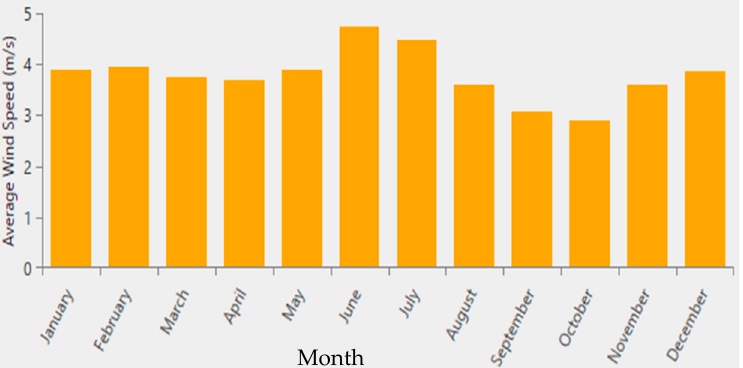
Figure 4. Average wind speed data.